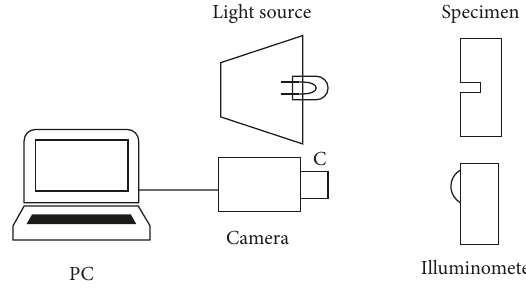
Figure 3: Schematic of the experimental